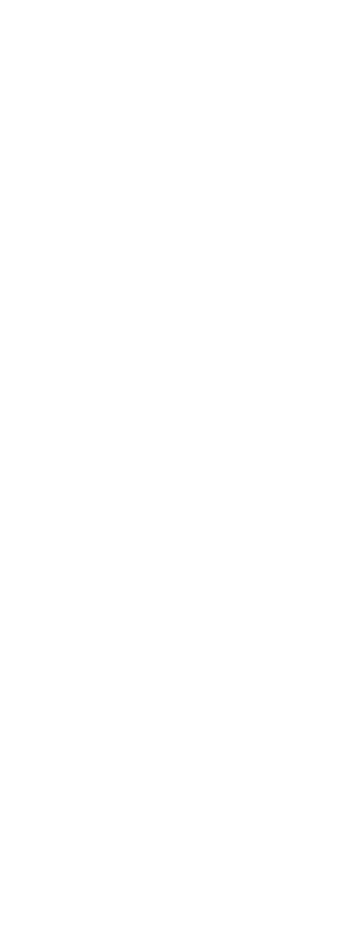
FIGURE 2 | Liver glycometabolism enzyme activities of L. maculatus fed experimental diets. PFK, phosphofructokinase; PK, pyruvate kinase; GK, glucokinase. T1, basal diet; T2, basal diet supplemented with 1 g/kg of condensed tannins; T3, basal diet supplemented with 2 g/kg of condensed tannins; T4, basal diet supplemented with 2 g/kg of condensed tannins and 4 g/kg of polyethylene glycol. (a-c) Different lowercase letters above the bars denote signi fi cant differences among diets ( P <